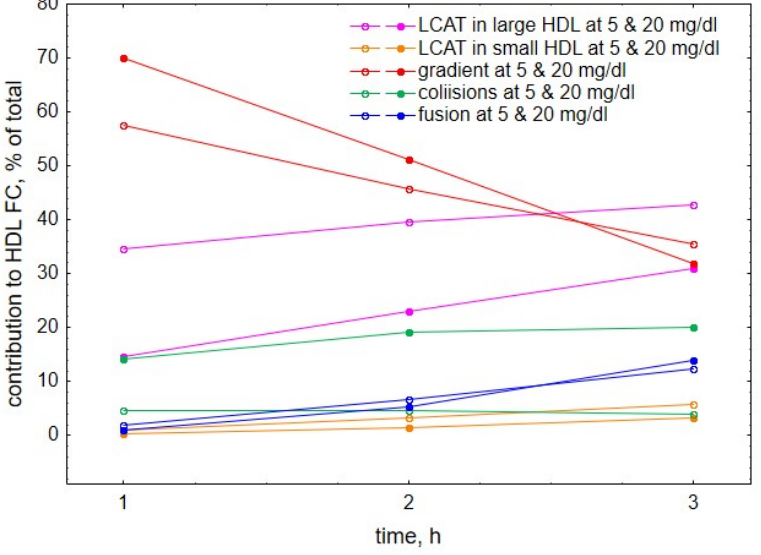
Figure 7. Relative contributions to HDL-FC provided by individual processes , including LCAT- mediated formation of CE from FC in large, lipid-rich, spherical HDL (purple), LCAT-mediated formation of CE from FC in small, lipid-poor, discoidal HDL (brown), FC transfer from VLDL to HDL under the action of FC concentration gradient (red), FC transfer to HDL upon collisions between VLDL and HDL particles (green) and FC transfer to HDL upon fusion of lipid-poor apoA-I with lipid-rich HDL (blue). All negative contributions were converted into positive and relative contributions of all processes were calculated as percentages of their sum. For the sake of simplicity, data are only shown for two HDL concentrations of 5 and 20 mg/dL. Mathematical modelling was performed under conditions of in vitro TGRL lipolysis described elsewhere [25]. In order to calculate accumulation of FC in HDL, its content at baseline (t = 0) was subtracted from the results of the modelling. Initial concentrations: VLDL-TG, 30 mg/dL; LPL, 190 U/mL.